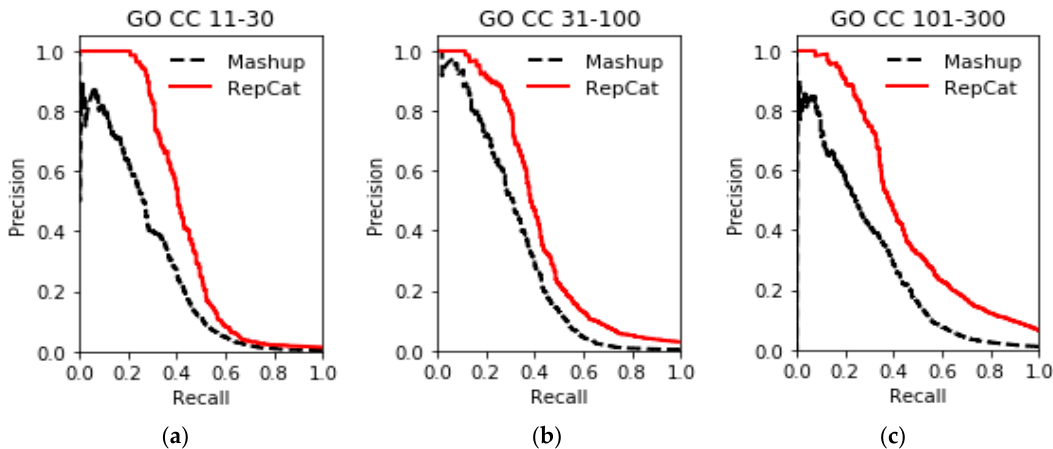
Figure 6. Performance comparison of GO CC function prediction on human datasets between ReprsentConcat and Mashup: ( a ) GO CC 11-30; ( b ) GO CC 31-100; and ( c ) GO CC 101-300.